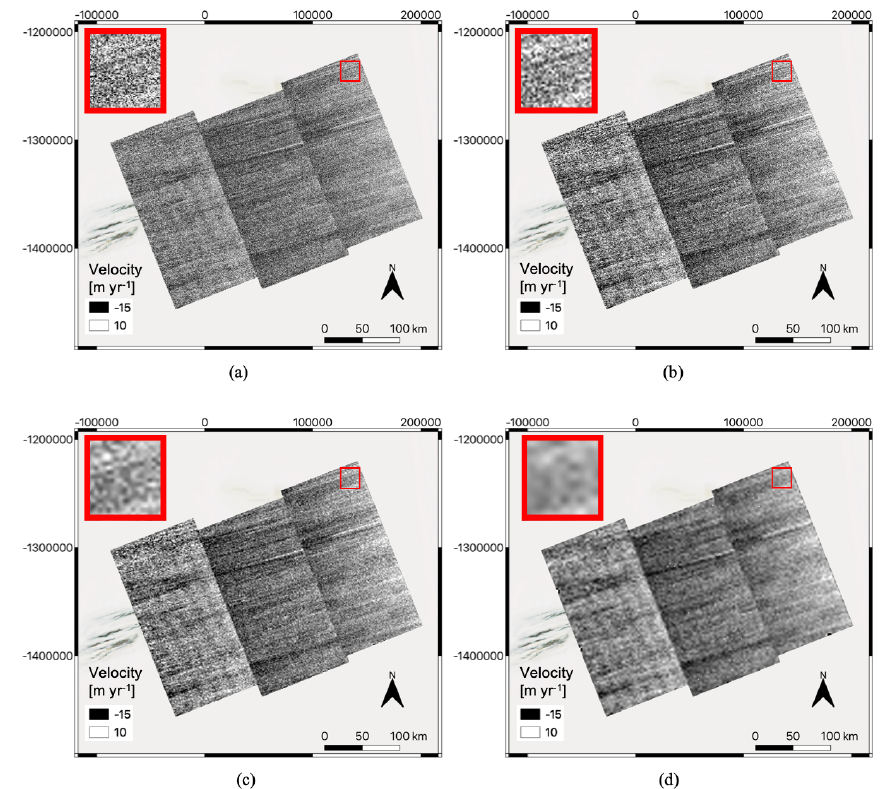
Figure 5. X -velocity from offset tracking using chip sizes of (a) 240m, (b) 480m, (c) 960m, and (d) 1920m. The same subpixel oversam- pling ratio of 1 / 128 is used for all cases. The Region 2 Sentinel-1 image pair 20171226–20180101 is used. Background: © Microsoft Bing Maps